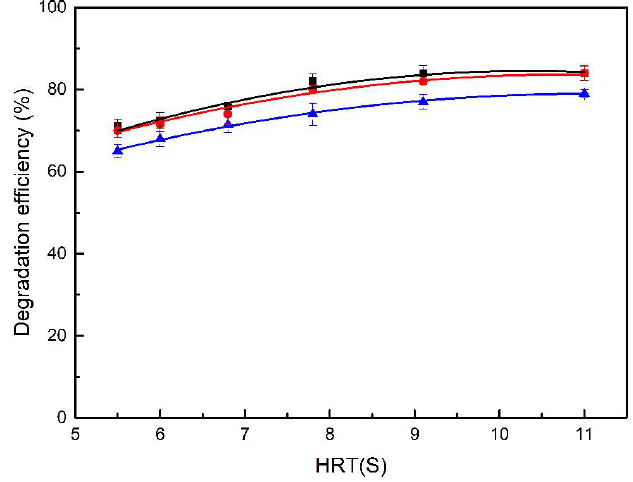
Figure 5. Influence of residence time on chlorobenzene degradation. ( ■ 300 mg·m −3 , ● 600mg·m −3 , ▲ 1000mg·m −3 ) (Oxygen concentration = 10%, chlorobenzene inlet concentration =300–1000 mg·m −3 ).